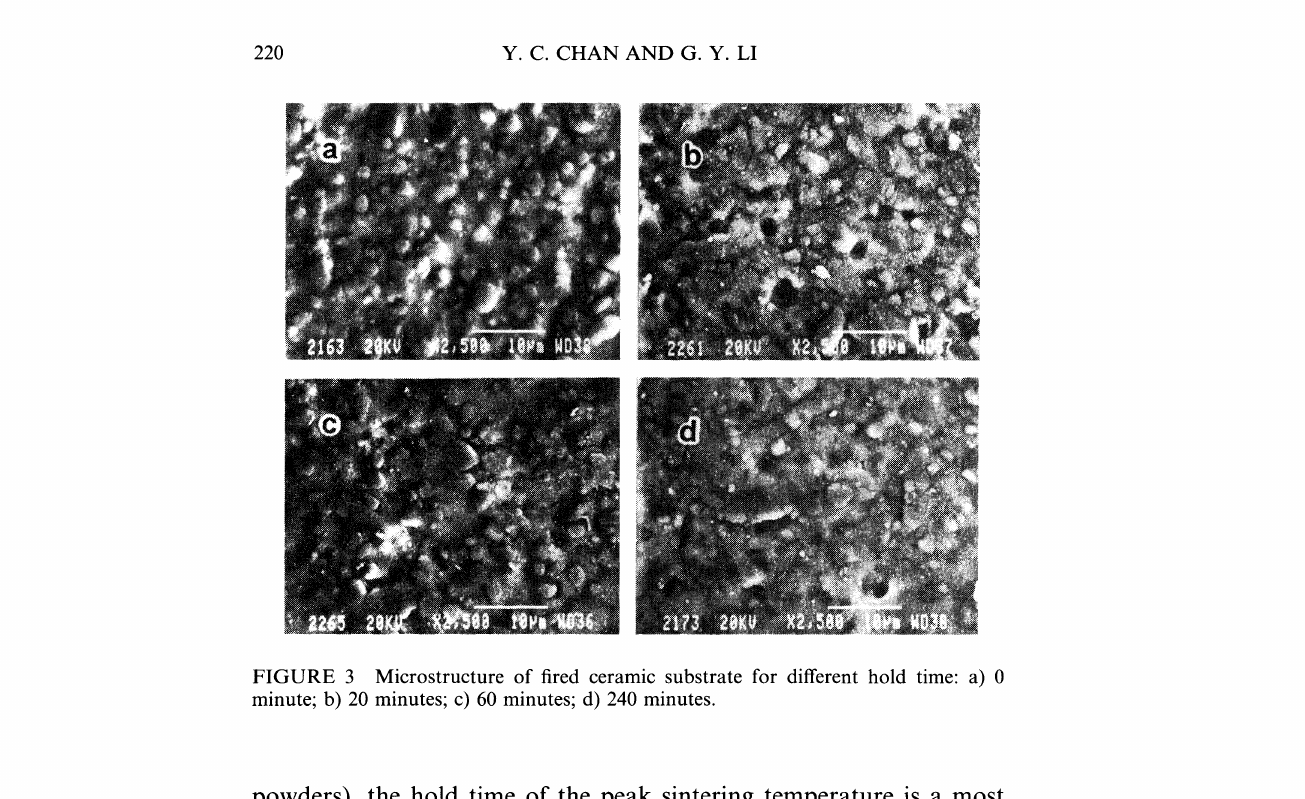
FIGURE 3 Microstructure of fired ceramic substrate for different hold time: a) 0 minute; b) 20 minutes; c) 60 minutes; d) 240